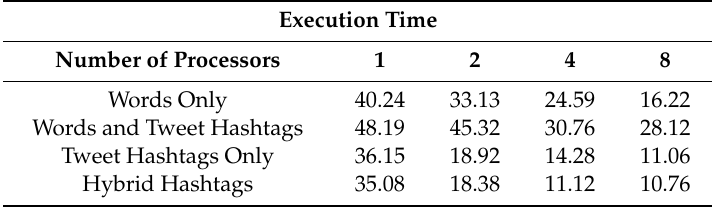
Table 10. Speed up for HHTC (in seconds) with di ff erent numbers of nodes for di ff erent sets of